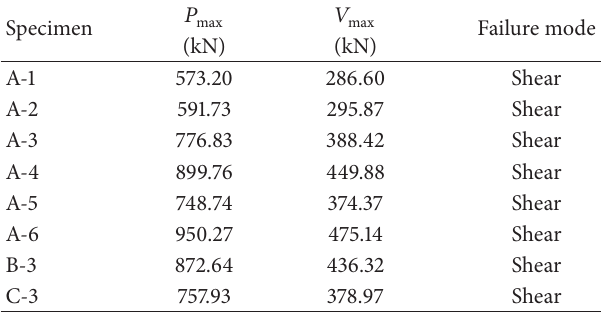
Figure 7: Shear resistance by FRP shear reinforcement.